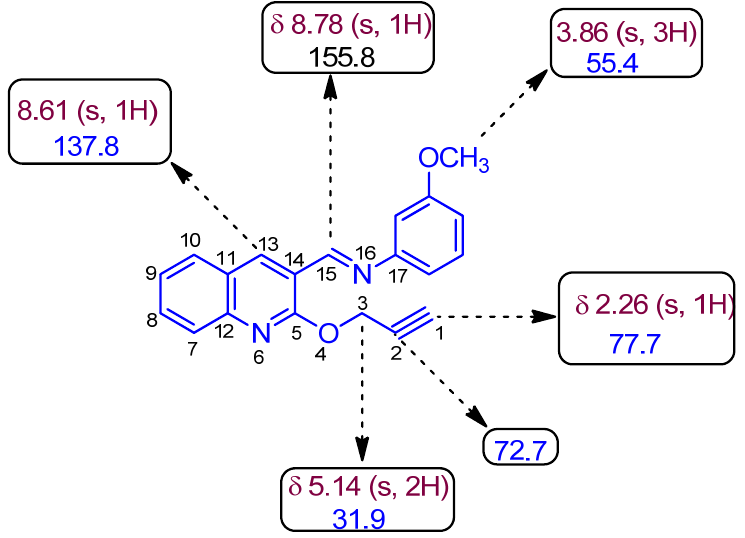
Figure 1. Selected chemical shift of 5g .